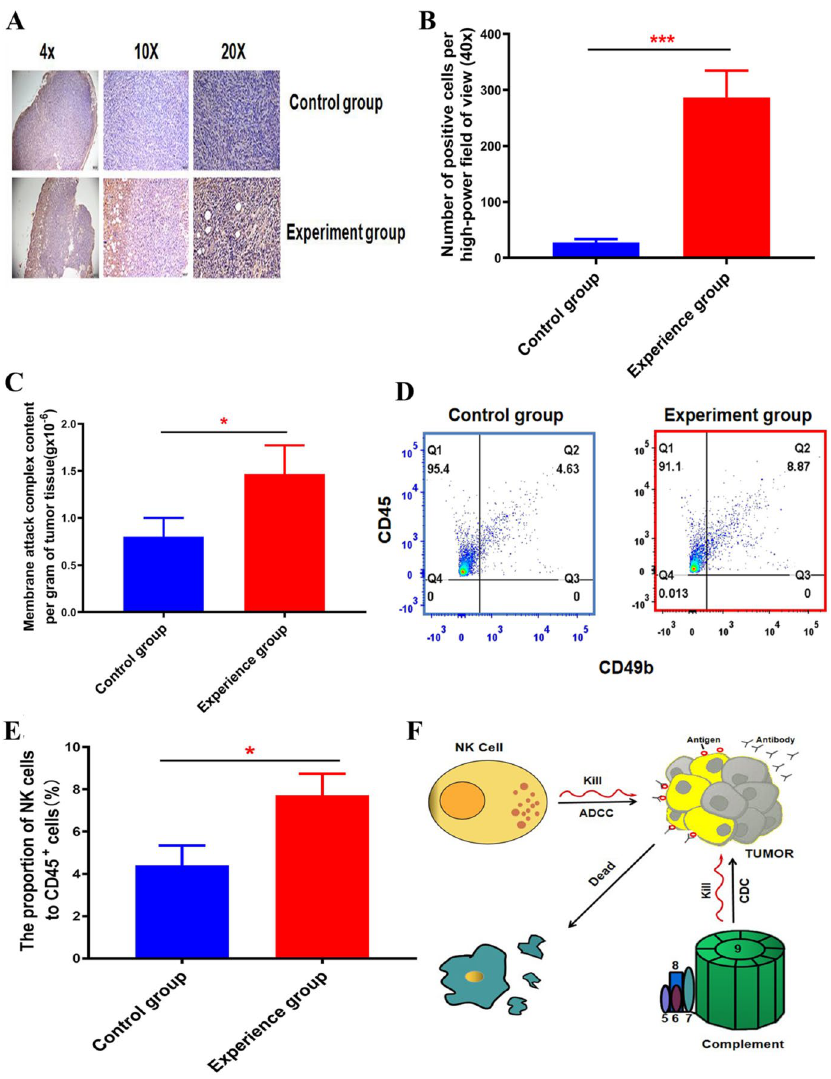
in mouse tumor tissues infected with blood group antigen lentivirus. ( B ) Count the number of positive tumor cells attacked by complement in each high-power field under the microscope. Student’s t-test, mean ± SD, *** P < 0.001. ( C ) Detection of C5b-9 membrane attack compound content. After extracting total protein from the obtained tumor tissue, the protein was quantified by BAC method. ELISA method to detect the content of C5b-9 complement complex. C5b-9 complement complex content per gram of tumor tissue = C5b-9 complement complex content/total protein content. Student’s t-test, mean ± SD, * P < 0.05. ( D – E ) Calculate the proportion of NK cells in all immune cells using flow cytometry. Student’s t-test, mean ± SD, * P < 0.05. ( F ) The mechanism diagram of ABO blood group antigen treatment of tumors. It was drawn using WPS Office (2019 PC version, China)